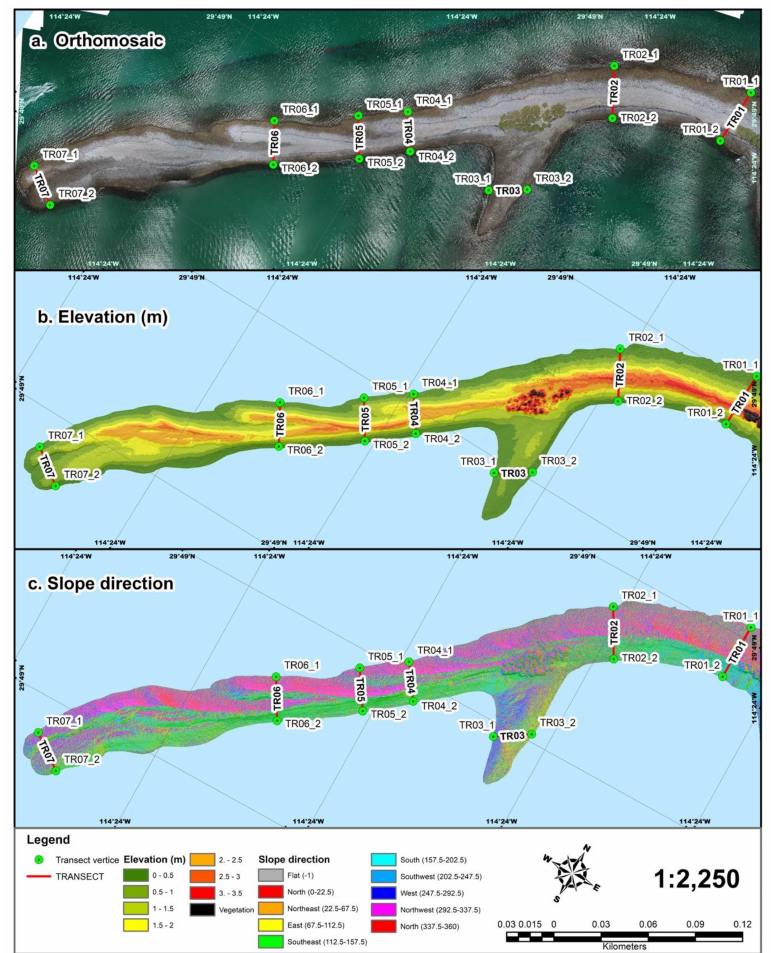
Figure 2. Base maps for the unconsolidated spit o ff the northeast end of Isla San Luis Gonzaga; ( a ) Orthophoto mosaic under natural light showing the position of transects 1 to 7; ( b ) Orthophoto color-coded map showing variations in elevation above mean sea level; ( c ) Color-coded map showing variations in slope